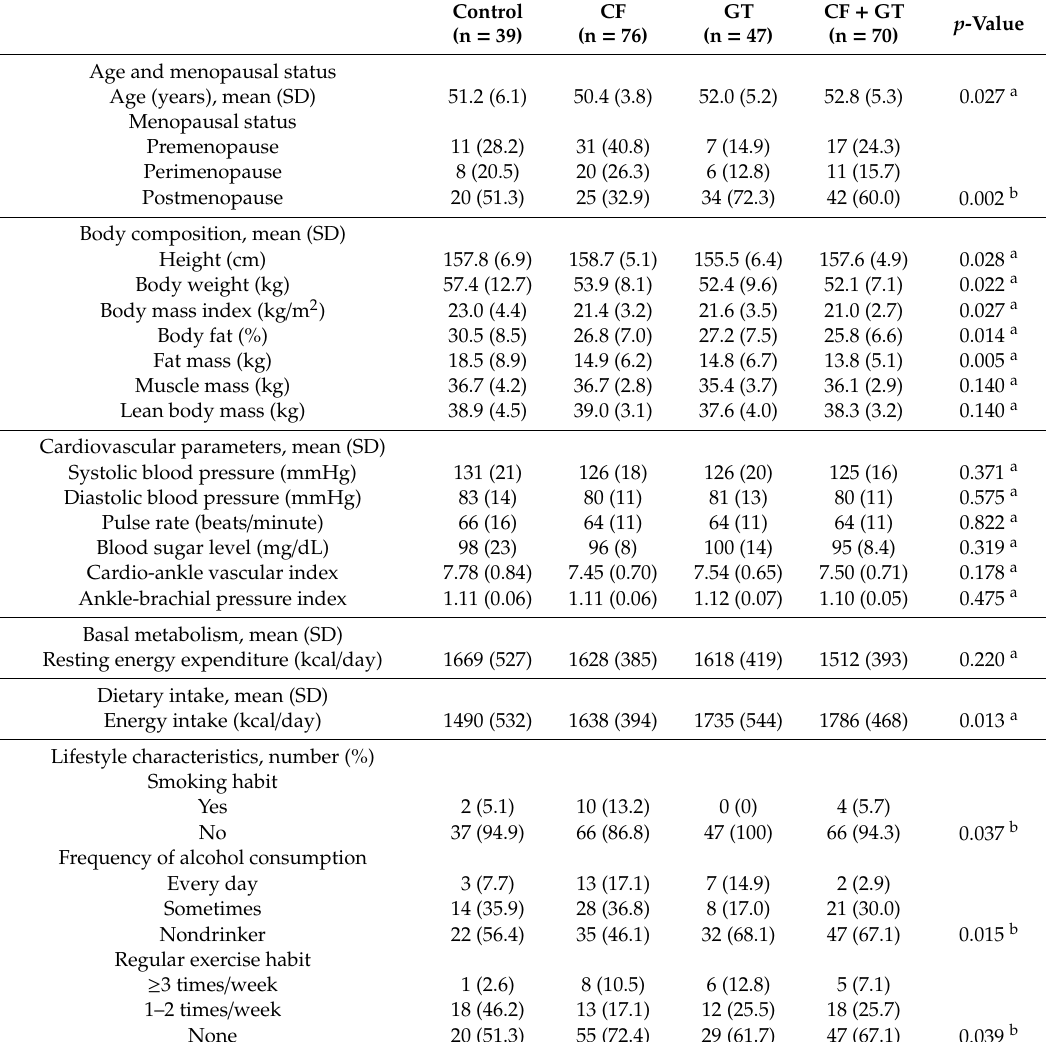
Table 1. Comparison of background characteristics and daily consumption of co ff ee (CF) and green tea